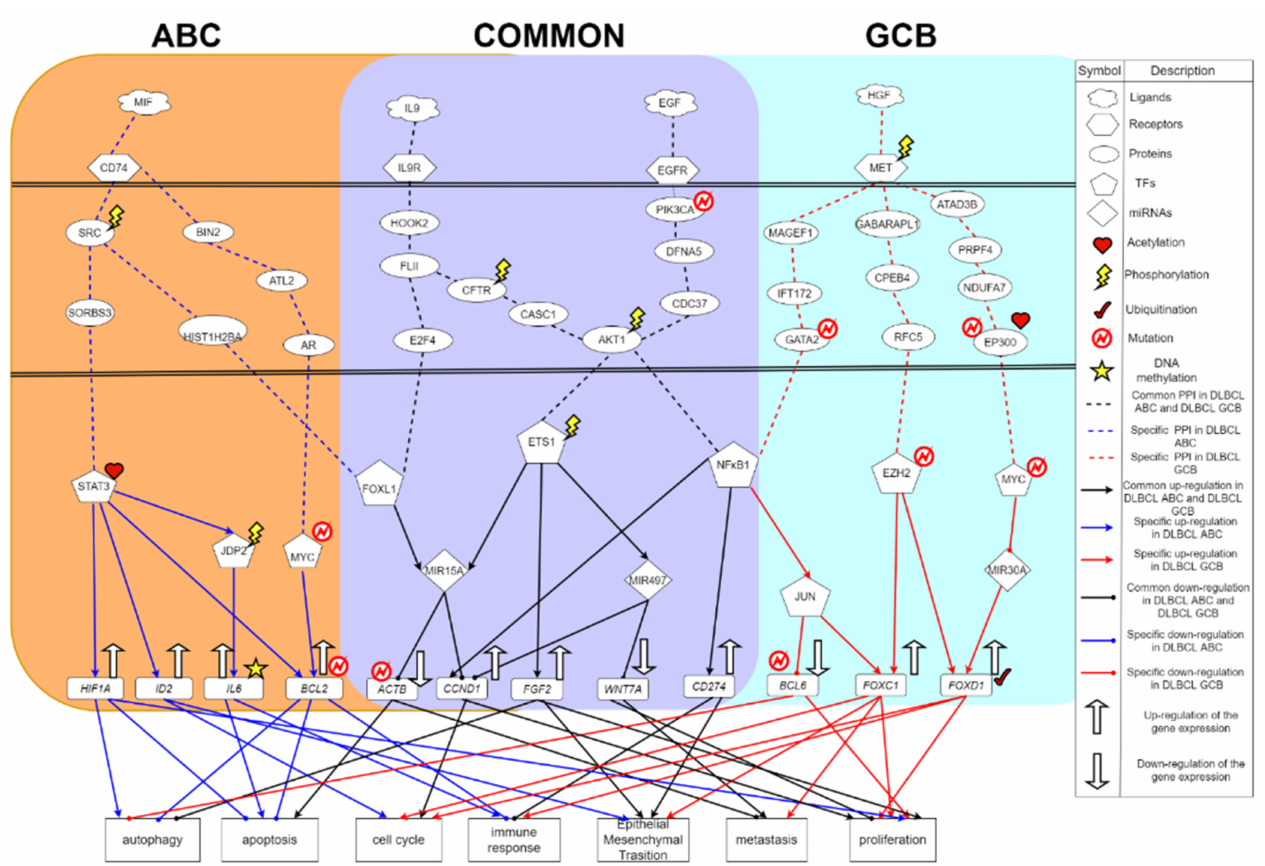
Figure 4. The common and specific core signaling pathways of DLBCL ABC and DLBCL GCB. This figure summarizes the genetic and epigenetic pathogenic molecular mechanisms of DLBCL ABC and DLBCL GCB. The core signaling pathways shown in the purple background are the common core signaling pathways of DLBCL ABC and DLBCL GCB. The blue line indicates specific core signaling pathways of DLBCL ABC; the red line indicates specific core signaling pathways of DLBCL GCB; the black line indicates common core signaling pathways of DLBCL ABC and DLBCL GCB; the arrow head of solid lines means activating cellular functions; the circle head of solid lines means inhibiting cellular functions. The up arrow on the target gene indicates an up-regulation. The down arrow on the target gene indicates a